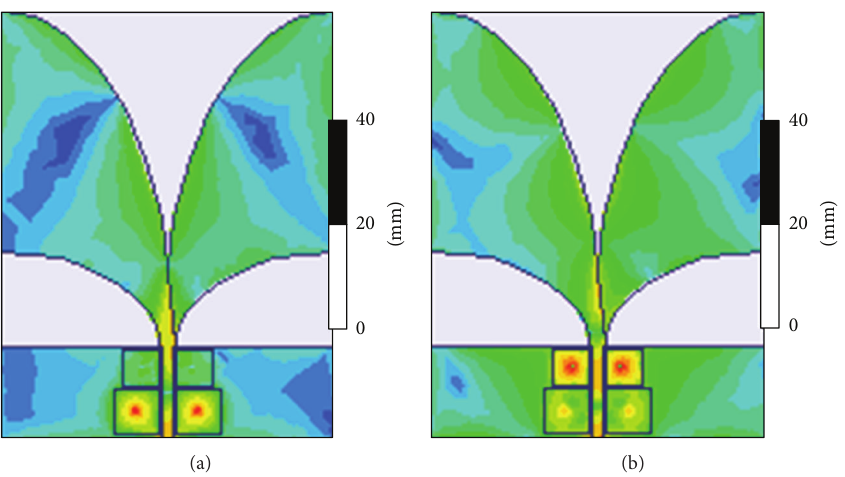
Figure 6: Current distribution of the proposed dual-notch AVA at (a) 3.8 GHz and (b) 5.7 GHz.